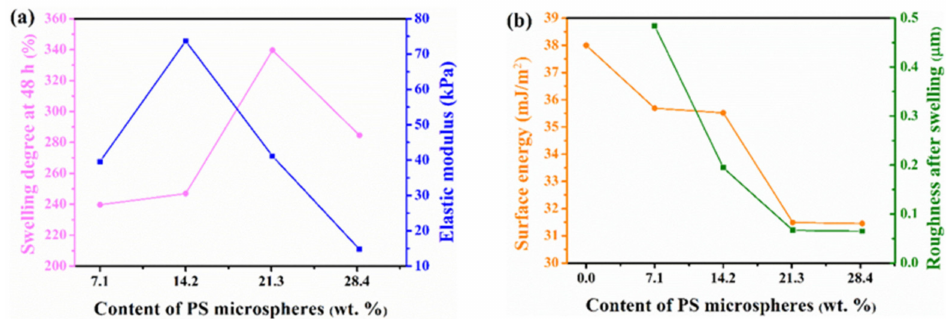
Figure 15. Changes in various properties with the content of PS microspheres ( a ) swelling degree and mechanical properties; ( b ) surface energy and roughness.